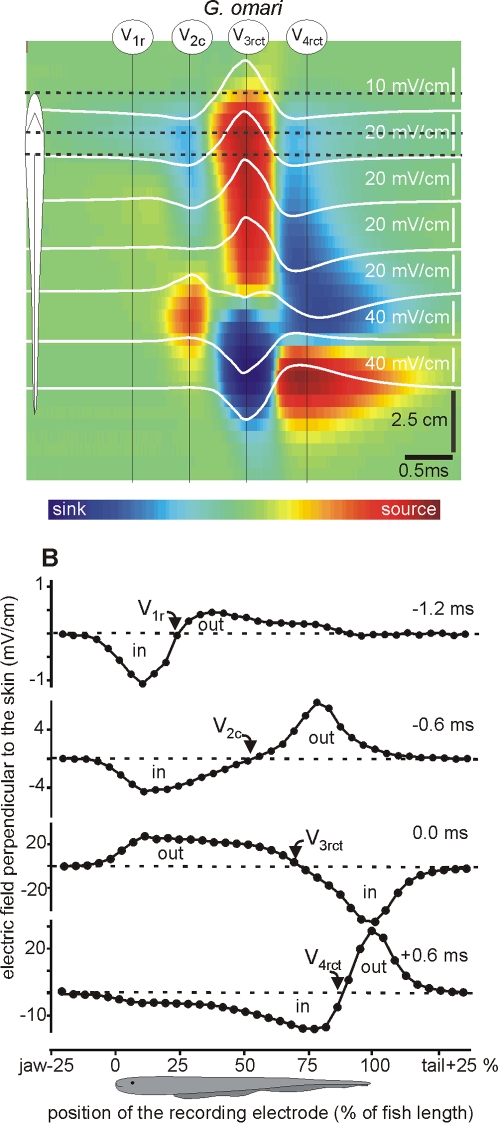
Transcutaneous current pattern of G. omari.Electric field perpendicular to the main axis of the fish body was recorded along a line 2 mm parallel to the mid-flank of G. omari. White traces correspond to the recorded field at equally separated points 2 mm from the skin on the side of the fish. These traces are superimposed on a color-map indicating the location of the sources (yellow-red-brown) and sinks (sky blue-deep blue) along the fish body (vertical axis) as the electric organ discharge progresses in time (horizontal axis); greenish correspond to negligible fields. G. omari shows 4 main components: V1r inverting about the origin of the anal fin; V2c inverting about half of the body; V3rct and V4ct inverting at the tail region. In this case there is a close correlation between temporal order and spatial origin of the components. For the sake of generality we used numeral sub index indicating the temporal order and a literal sub index indicating the spatial origin (r for rostral, c for central, and t for tail).